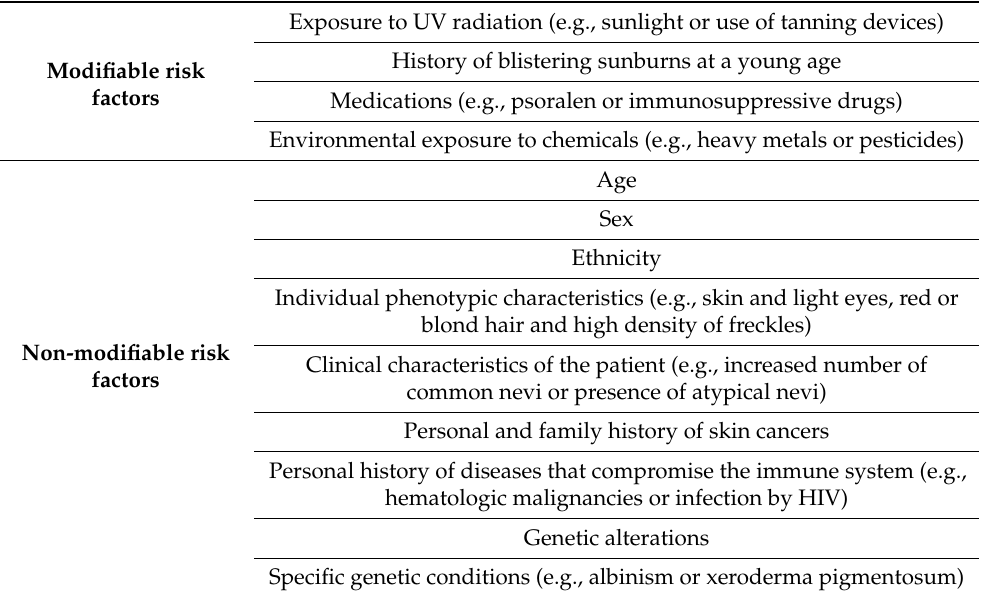
Table 1. Modifiable and non-modifiable risk factors of melanoma [15,21,76–78]. Exposure to UV radiation (e.g., sunlight or use of tanning devices) History of blistering sunburns at a young age Modifiable risk factors Medications (e.g., psoralen or immunosuppressive drugs) Environmental exposure to chemicals (e.g., heavy metals or pesticides) Age Sex Ethnicity Individual phenotypic characteristics (e.g., skin and light eyes, red or blond hair and high density of freckles) Non-modifiable risk Clinical characteristics of the patient (e.g., increased number of factors common nevi or presence of atypical nevi) Personal and family history of skin cancers Personal history of diseases that compromise the immune system (e.g., hematologic malignancies or infection by HIV) Genetic